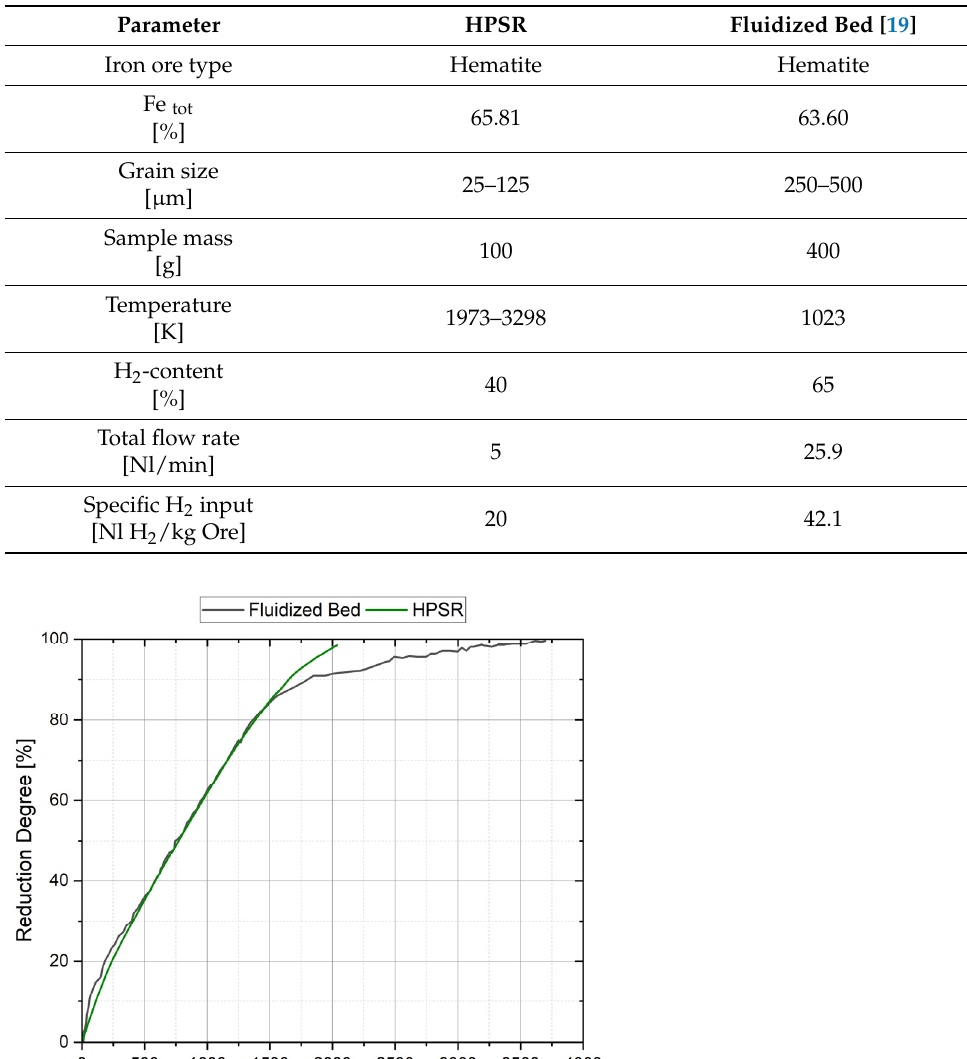
Table 5. Feedstock properties and process parameters of both tests.